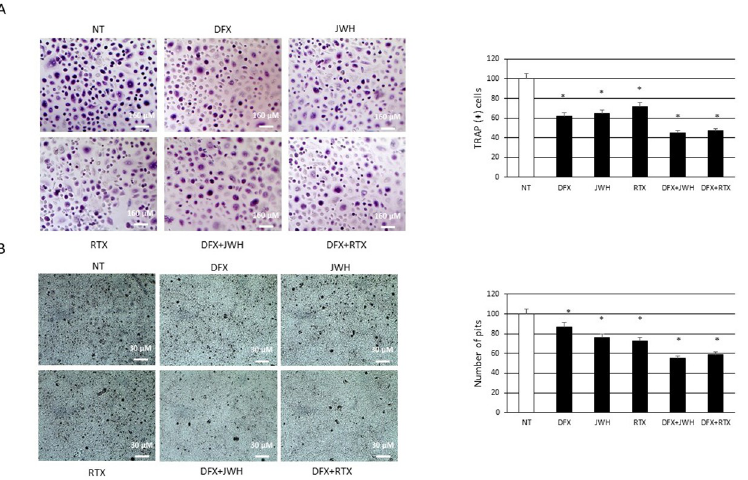
Fig 7. Effects of treatments on osteoclast number and activity. (A) TRAP assay on OCs, differentiated or not in presence of DFX [5 μ M], from 5 Childhood cancer survivors (CCS) after 48h of exposure with JWH-133 [100nM] and RTX [5 μ M]. The most representative images are showed (10x magnification). An AE2000 inverted microscope has been used to count TRAP (+) multinucleated (n � 3) OCs (stained purple) in at least three different wells for each individual sample. Histogram shows the percentage number of TRAP (+) cells respect to the total cell number for each sample as mean ± SD. (B) Bone resorption assay on OCs, differentiated or not in presence of DFX [5 μ M], from 5 Childhood cancer survivors (CCS) after 48h of exposure with JWH-133 [100nM] and RTX [5 μ M]. The most representative images are displayed (10x magnification). An AE2000 inverted microscope has been used to count the pits (represented in the image as darker areas) on the plate in at least three different wells for each individual sample. Histogram shows the percentage number of pits as mean ± SD. For statistical analysis it has been used ANOVA test followed by a post hoc test. � Indicates p � 0.05 compared to the untreated control (NT).